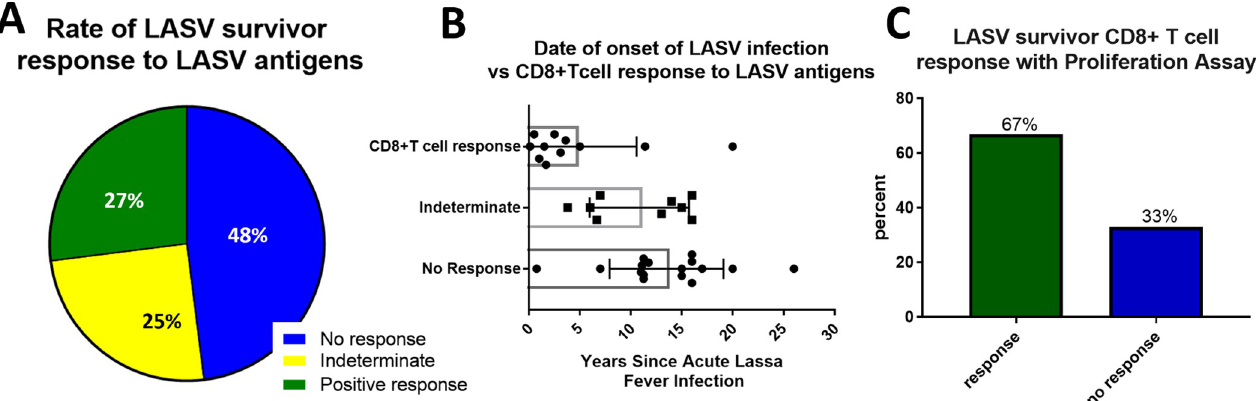
Fig 1. A Rate of CD8 + T cell response to LASV antigens. N = 93, including all LF survivors (with and without known date of infection); Responses were considered indeterminate if the LASV specific T cell response was present but background events in the negative controls and stimulated samples was high. B CD8 + T cell responses to LASV specific antigens in overnight assays in those with known date of onset of LASV infection (total N = 36); C Rate of response of LASV to proliferation assay, that were non-responders to standard overnight stimulation.